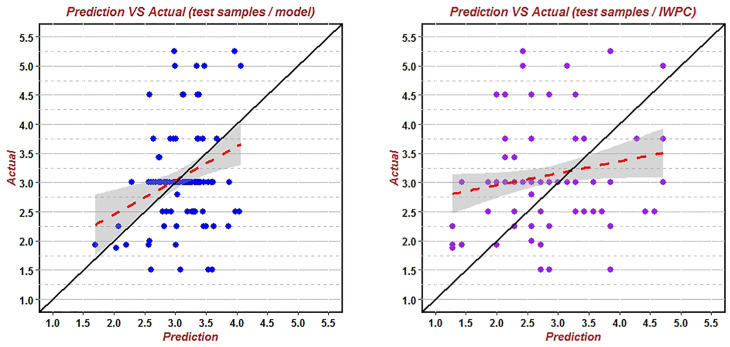
Predicted vs. actual warfarin stable dose verified by the new algorithm and IWPC algorithm using data of the remaining 120 patients over 65years. This was a scatter plot of the correlation between the predicted value and the actual value. The red line was the fitting line, and the black line was the theoretical line where the actual value and the predicted value were equal.